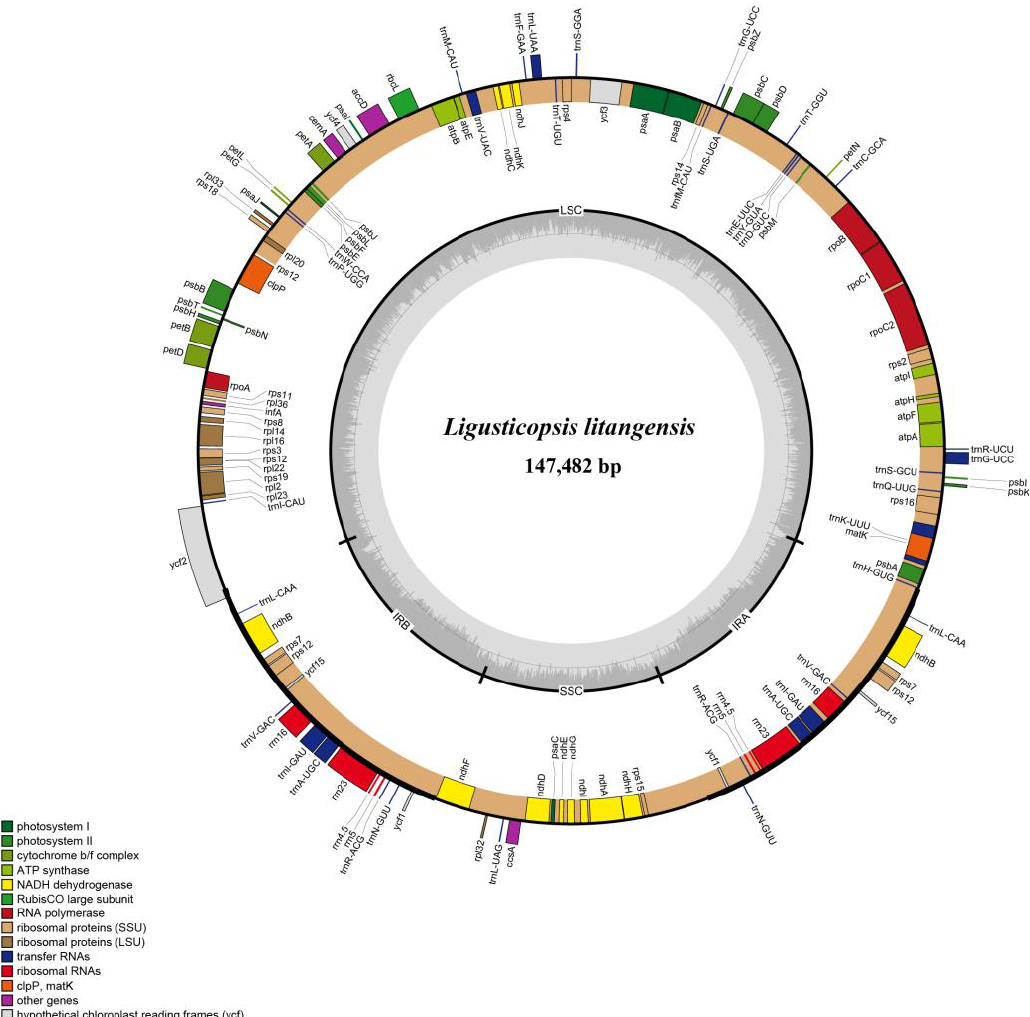
Figure 3. Gene map of the Ligusticopsis litangensis chloroplast genome.